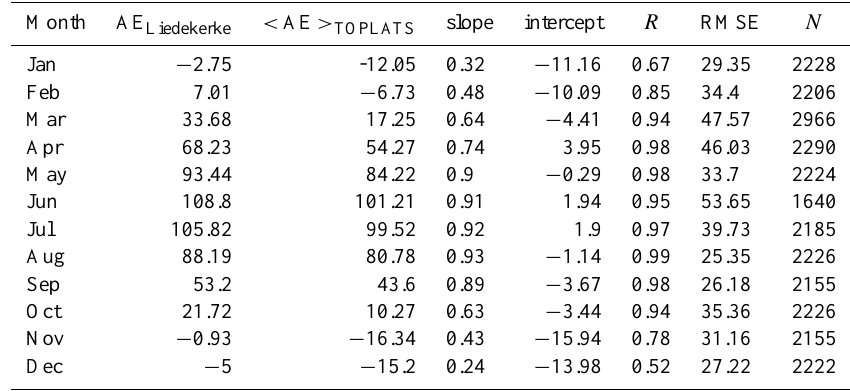
Table 2. Statistics of the comparison between AE Liedekerke and < AE > TOPLATS per month. Units are in Wm − 2 . Month AE Liedekerke < AE > TOPLATS slope intercept R RMSE N